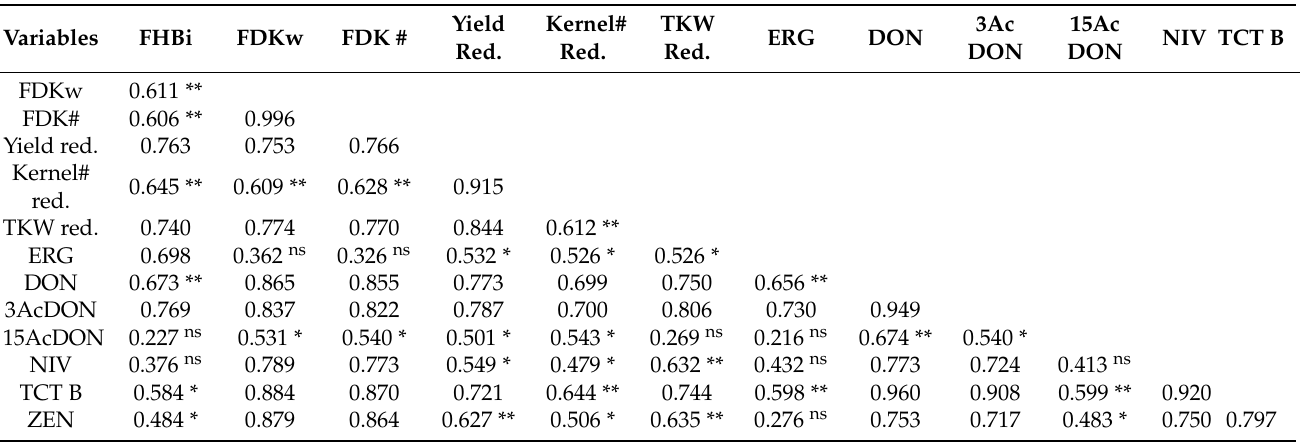
Table 4. Coefficients of correlation between Fusarium head blight index, Fusarium -damaged kernels proportion (weight, number), reductions in yield components and concentration of ergosterol and mycotoxins in grain of 15 winter triticale and three winter wheat lines.